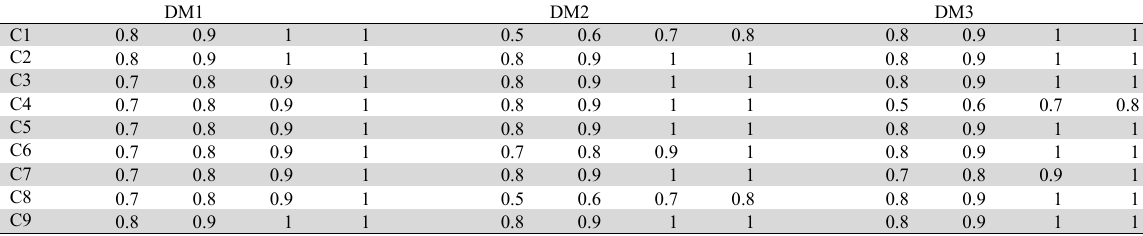
Rating of the criteria using fuzzy trapezoidal